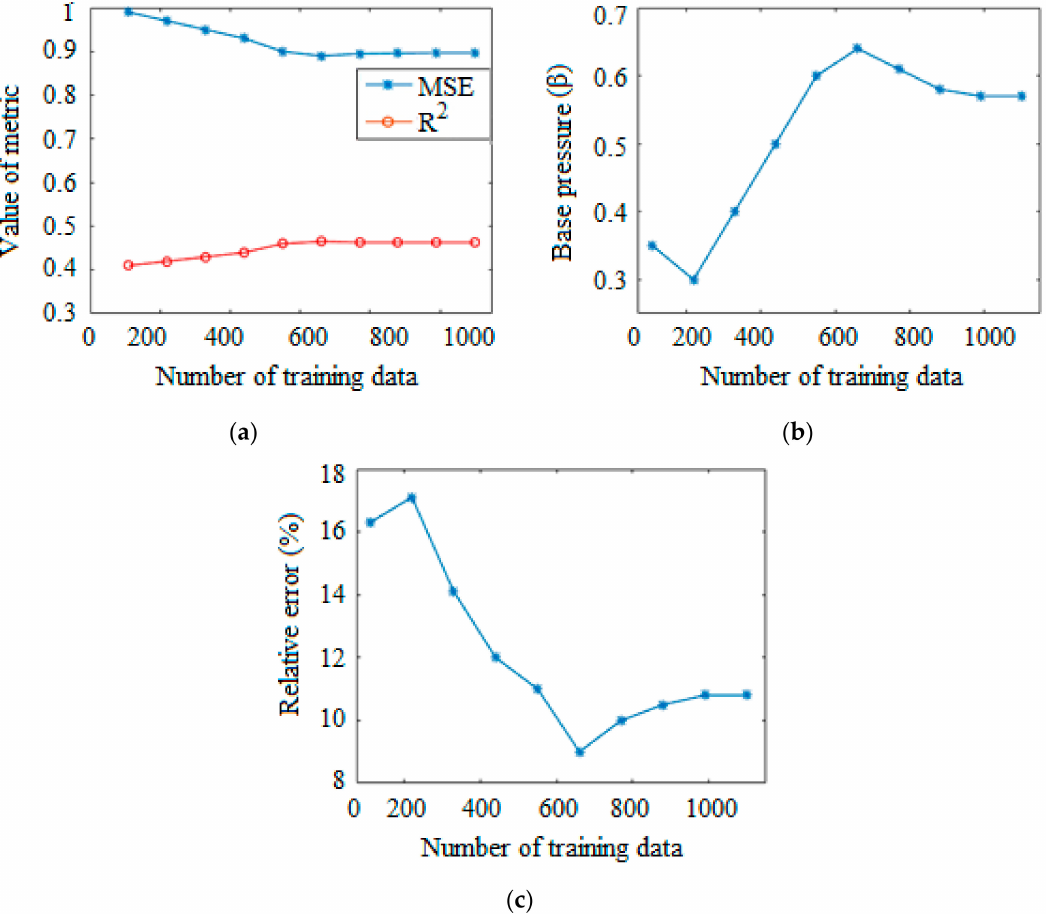
Figure 14. Variations in ( a ) metric value, ( b ) predicted base pressure ( β ), ( c ) relative error (%) versus training data of the SVM